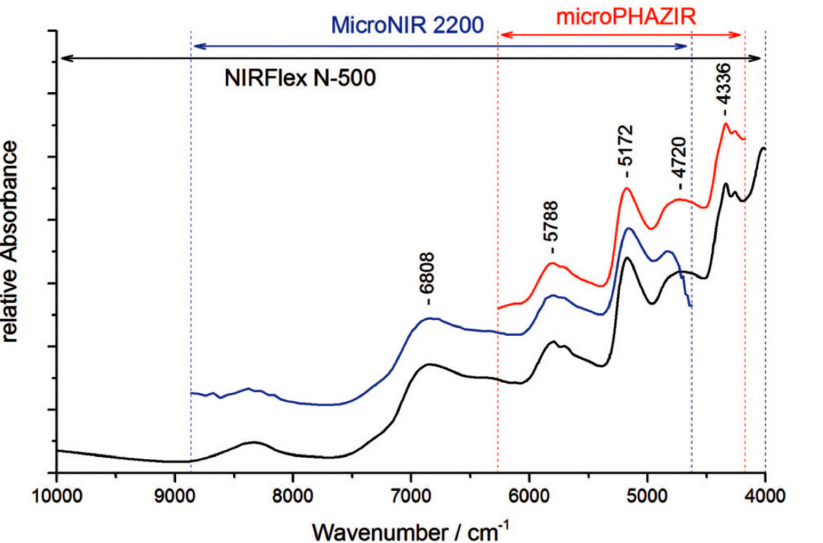
Figure 6. NIR spectra of Rosmarini folium samples measured on benchtop (NIRFlex N-500) and handheld (microPHAZIR and MicroNIR 2200) spectrometers. Reproduced with permission from Royal Society of Chemistry, Ref.